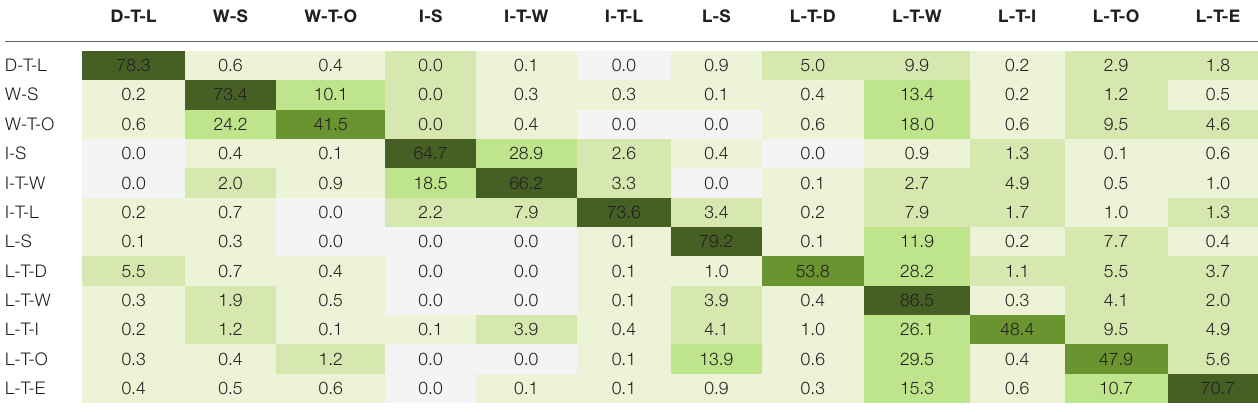
TABLE 7 | The multiclass confusion matrix for MobileNetV2 showing the image classification accuracies (%) during inference on the ExoNet database.